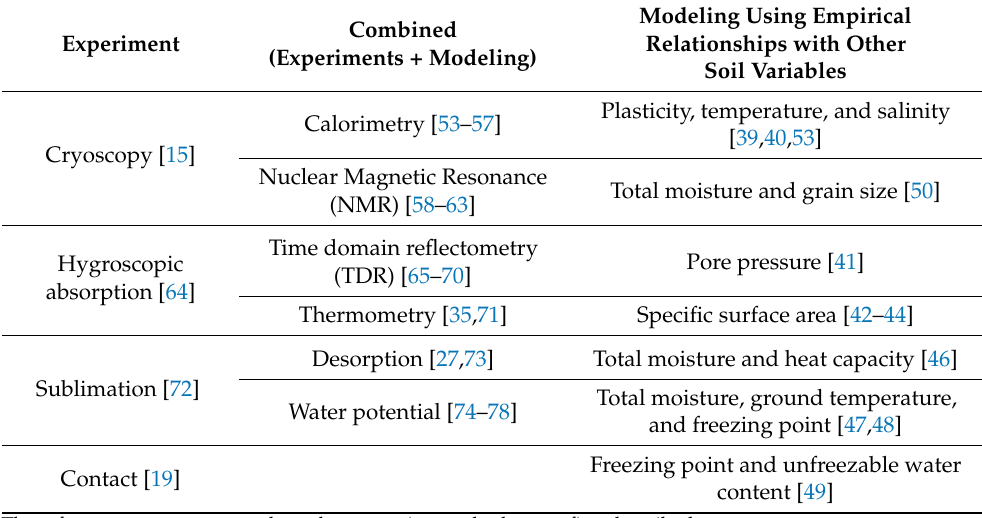
Table 1. Summary of methods for studying the phase composition of pore moisture in frozen